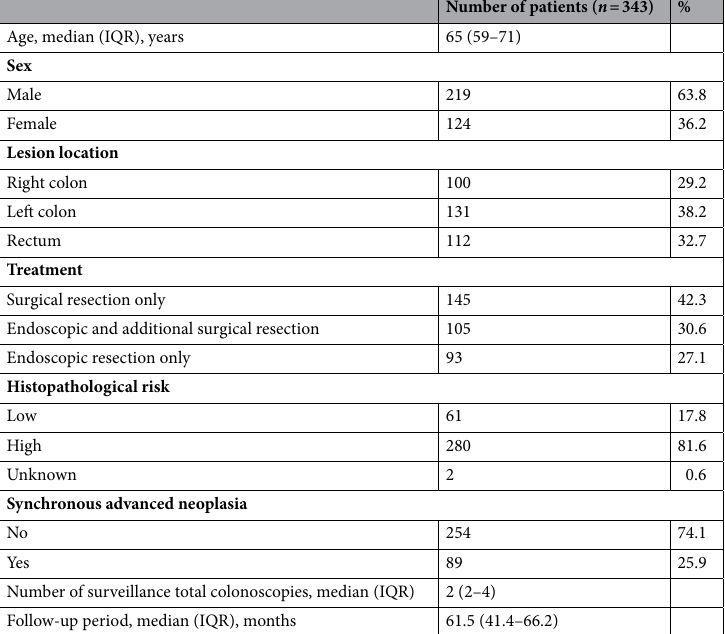
Table 1. Baseline characteristics of patients and submucosal invasive colorectal cancer. IQR interquartile